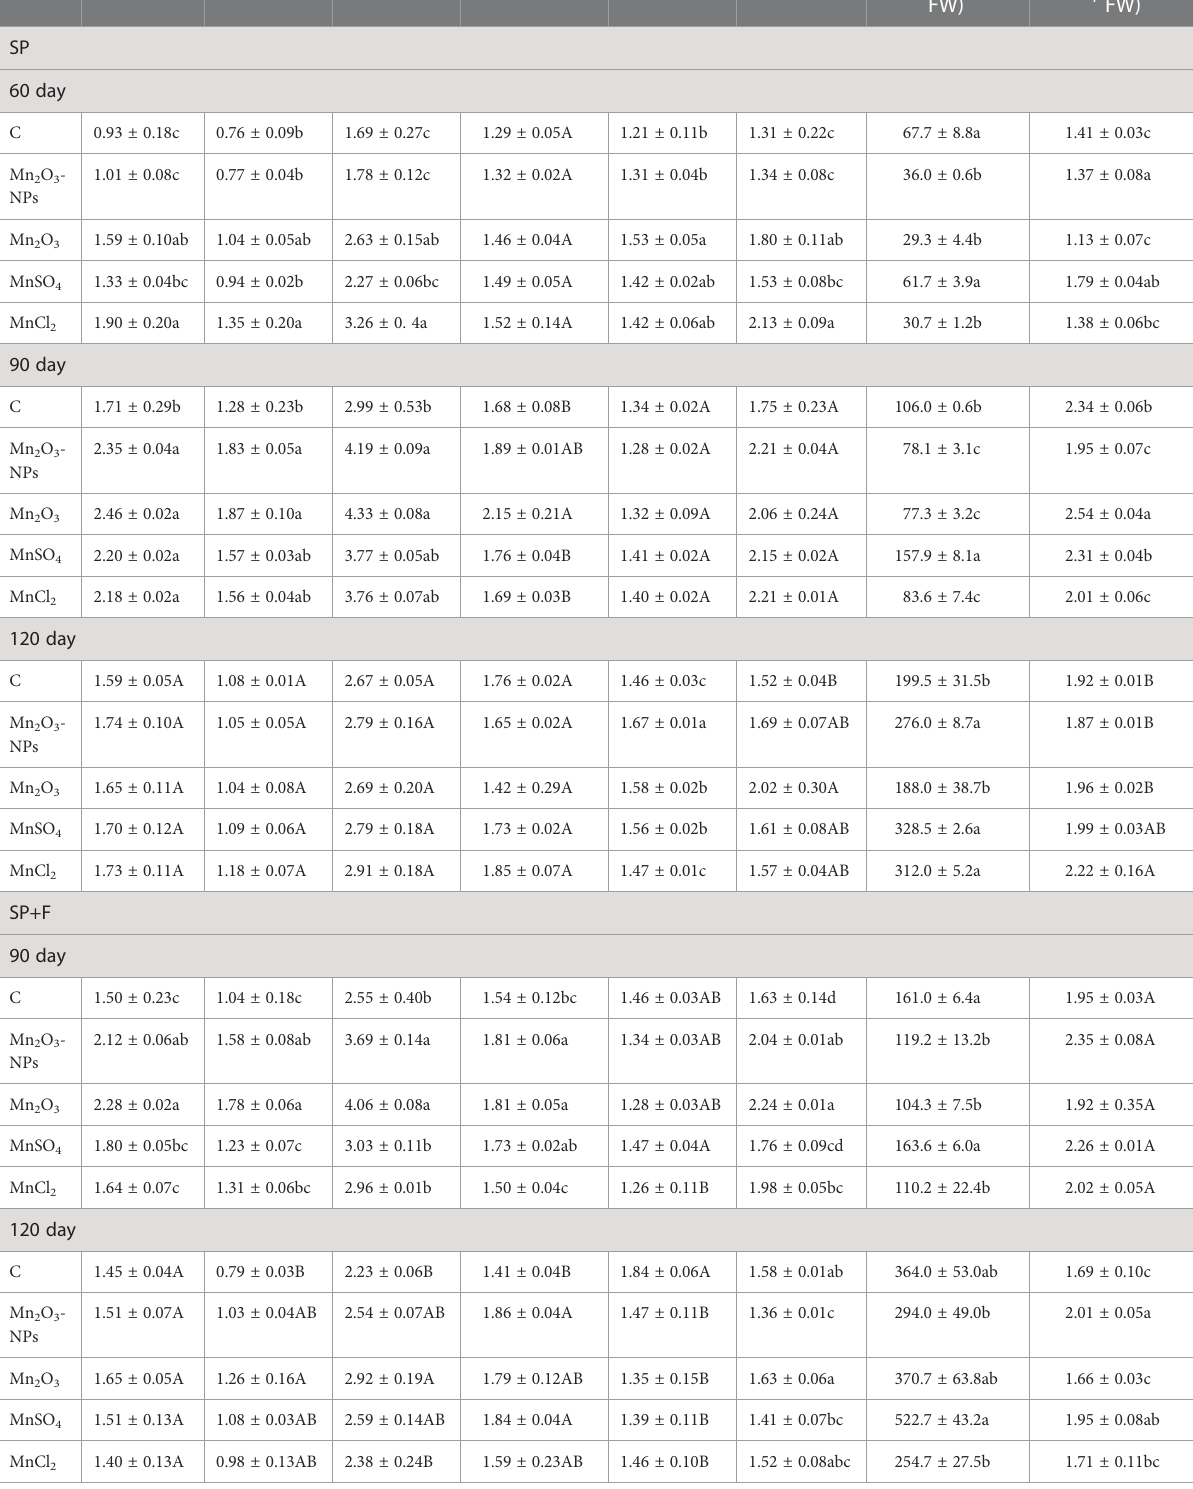
Data are expressed as mean+standard error. Different letters show signi fi cant differences between treatments. Capital letters represent no statistical difference among